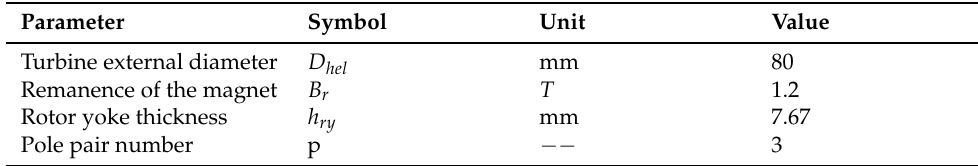
Table 1. Rim-Driven machine